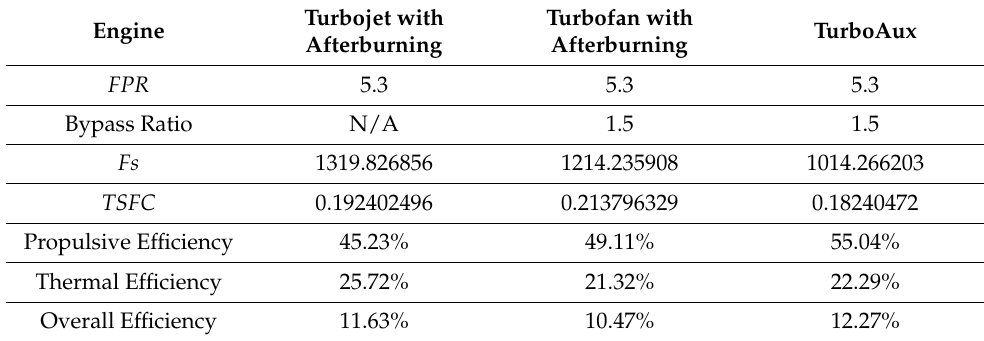
Table 8. Performance Results of Turbojet, Turbofan, and TurboAux at BPR of 1.5.